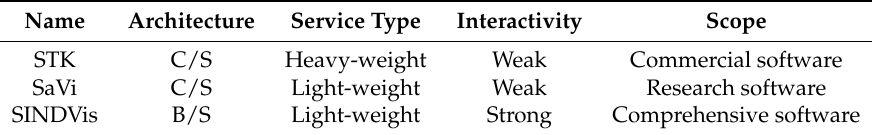
Table 3. Simulation platform contrast analysis in the entity